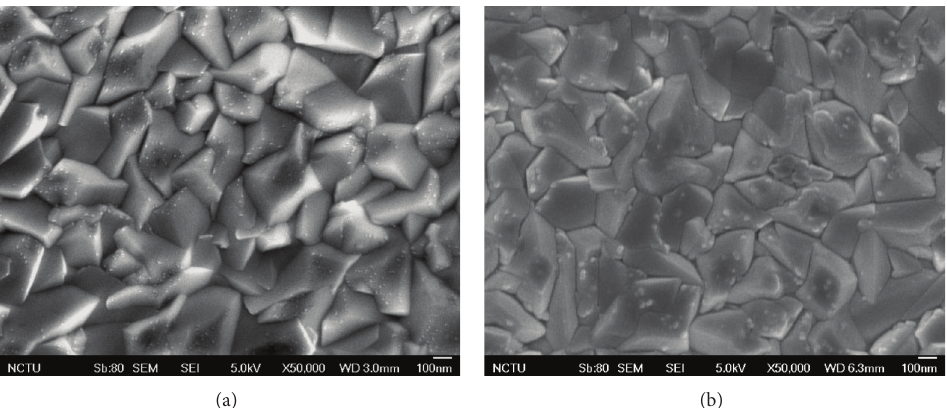
Figure 4: Plane-view SEM images of the 5 nm AZO capped FTO films (a) without and (b) with 72-second H 2 -plasma exposure.